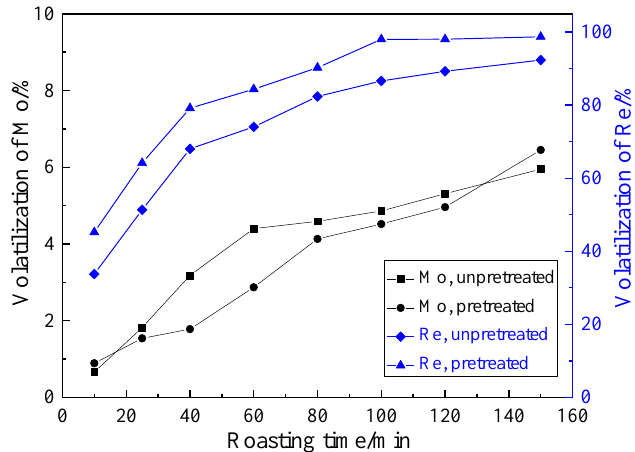
Figure 8. Effect of roasting time on the volatilization of Mo and Re.